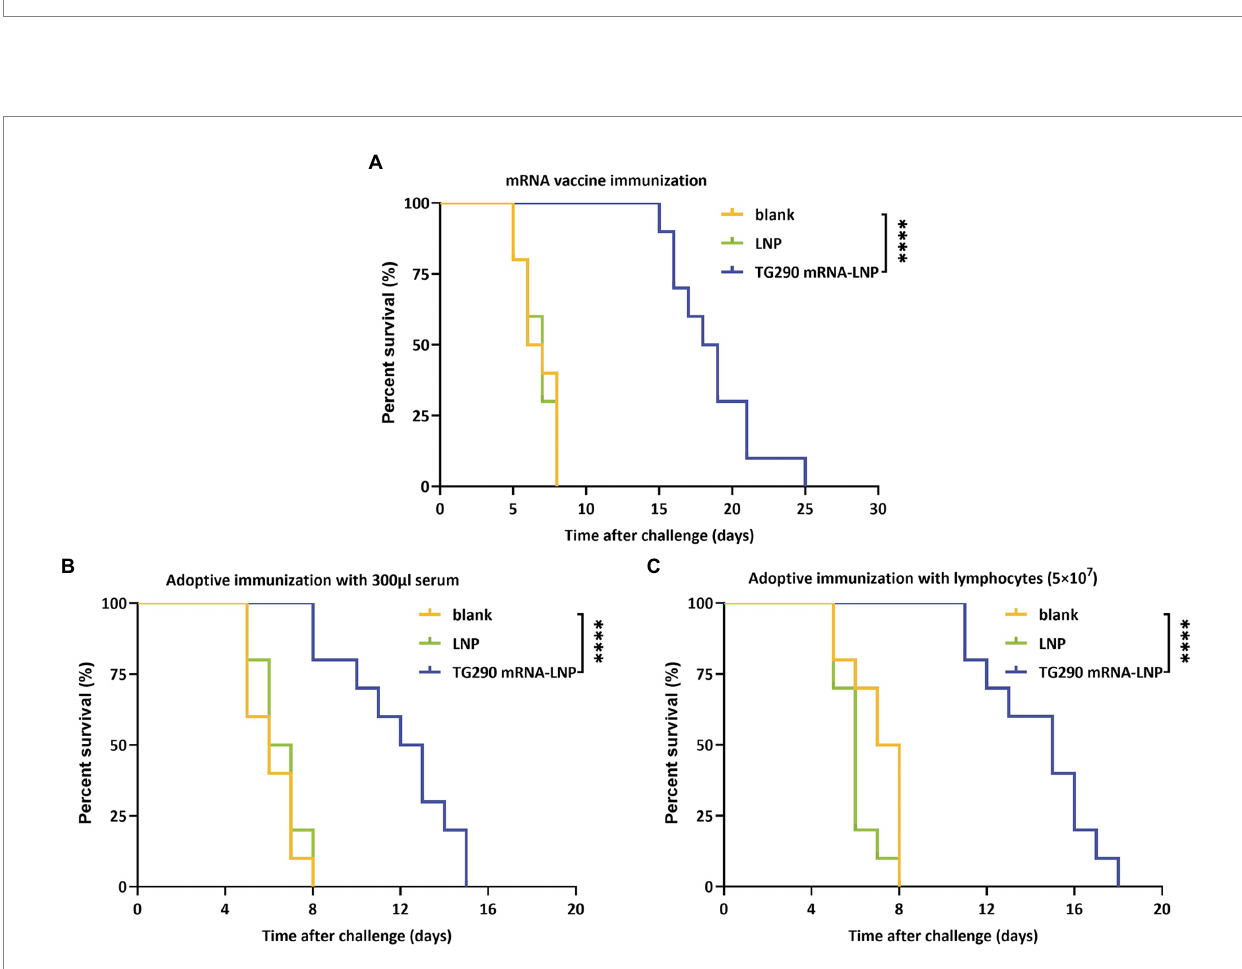
FIGURE 8 Survival curves of BALB/c mice after challenge. (A) TG290 mRNA-LNP vaccine protected against the lethal challenge (15 mice per group). (B) Adoptive immunization with serum protected against the lethal challenge (10 mice per group). (C) Adoptive immunization with lymphocytes protected against the lethal challenge (10 mice per group). **** p < 0.0001 by the log rank